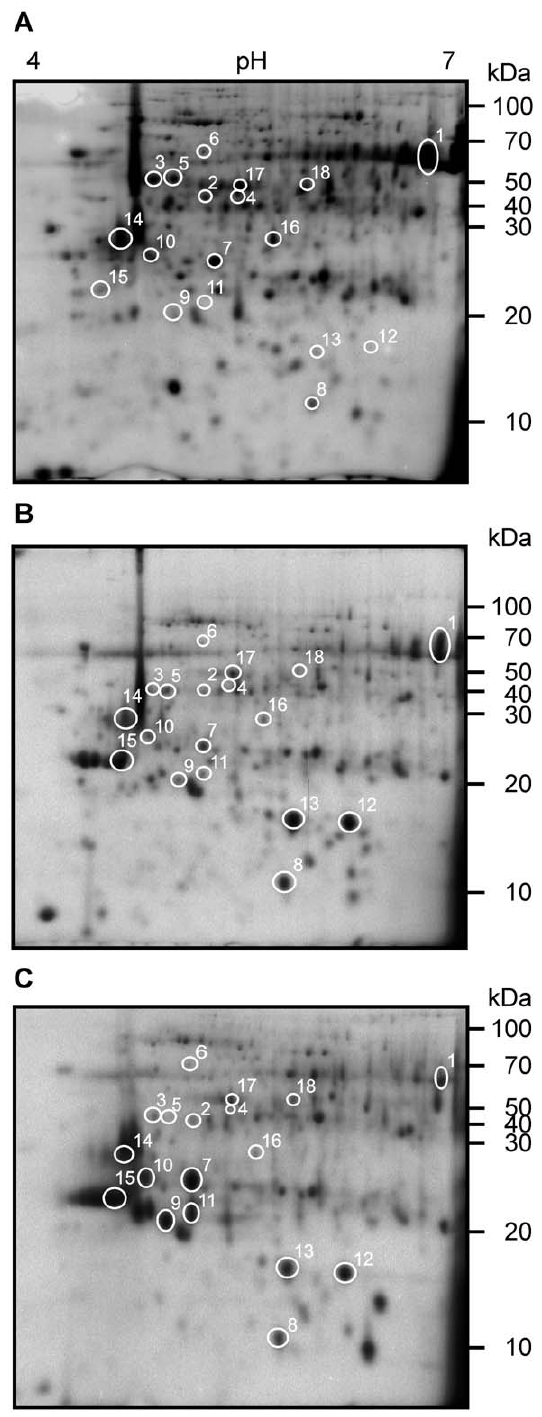
Figure 1. Protein profiles in 2-DE of total soluble proteins of Xcc-infected citrus leaves. Equal amounts of urea-buffer extracted proteins (200 m g) were separated on 7 cm pI 4–7 linear gradient strips in the first dimension and on 12% SDS-PAGE in the second dimension and stained with Coomassie blue. Proteins with significantly different expression levels between control and infected plants were marked with circles and numbered. Numbers refer to protein spot numbers on Table 1. Numbers on the right indicate molecular mass in kilodalton (kDa). (A) Citrus leaves infiltrated with Tris solution as control. (B) Citrus leaves inoculated with X. citri pv. citri 3 dpi and (C) 6 dpi.